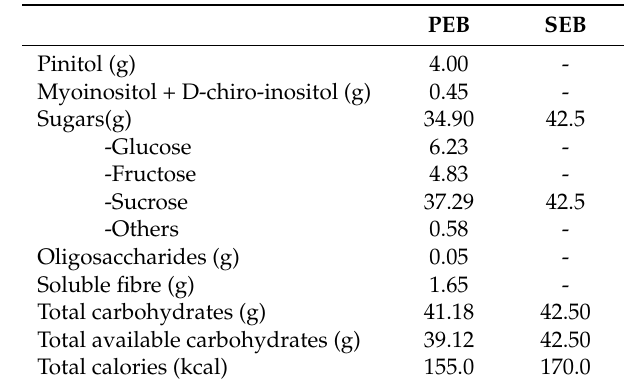
Table 1. Pinitol/sucrose-enriched beverage